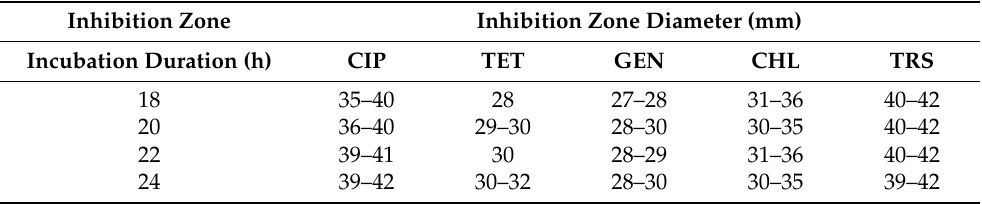
Table 7. Disc-diffusion inhibition zones of Y. pestis at various time points.